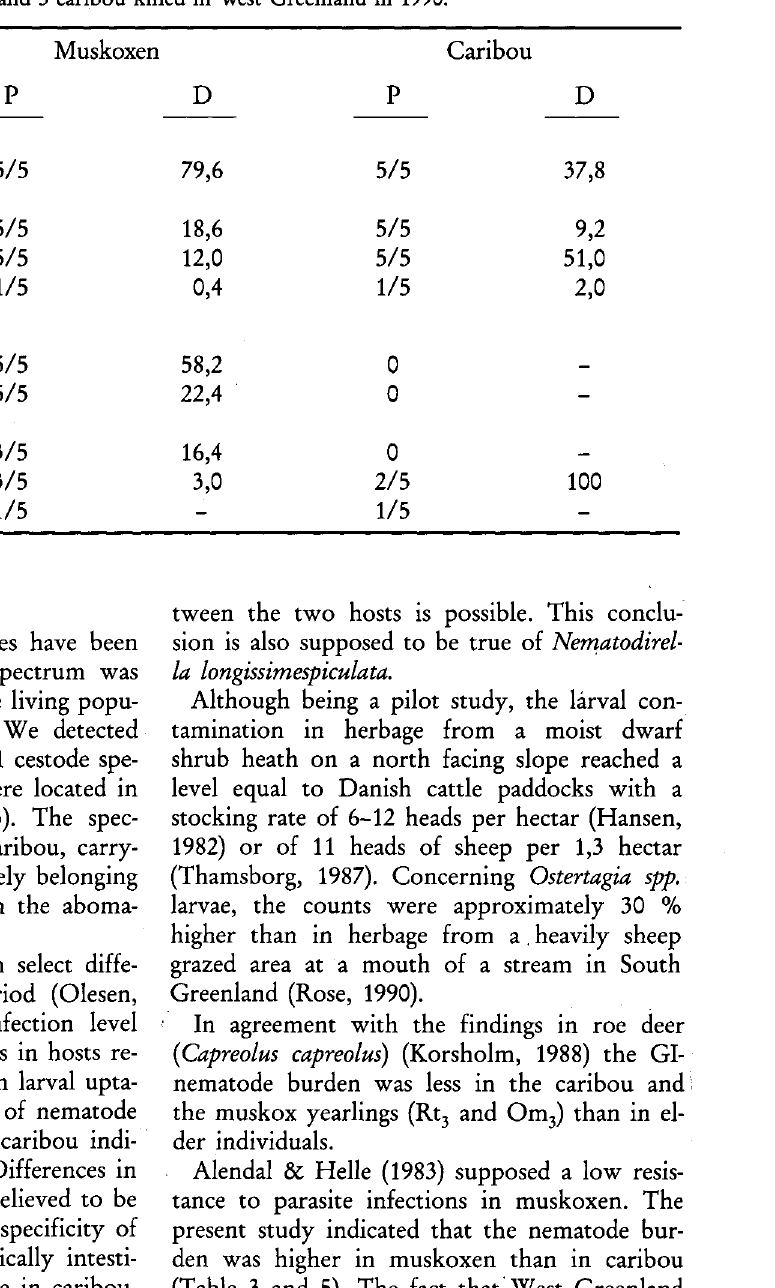
Table 5. Prevalence (P) of gastrointestinal nematode males and their procentual dominance (D) in abomasum and small intestine of 5 muskoxen and 5 caribou killed in West Greenland in 1990. Muskoxen